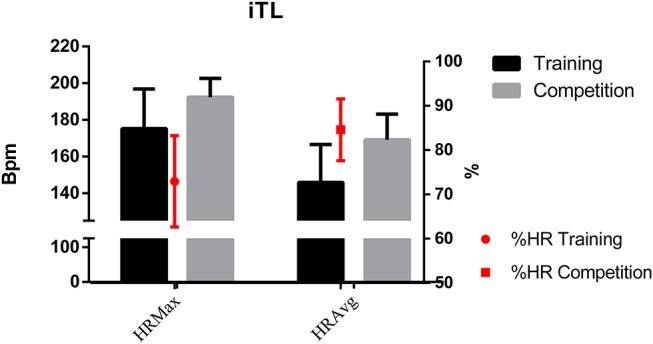
Internal load by game situation.